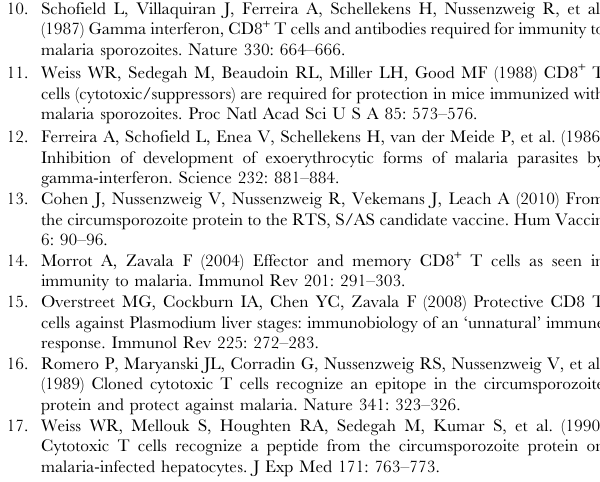
Table S1 Summary of datasets used in the epitope analysis. Table S2 Complete list of synthesised peptides. Table S3 Tolerisation and multiple immunisation